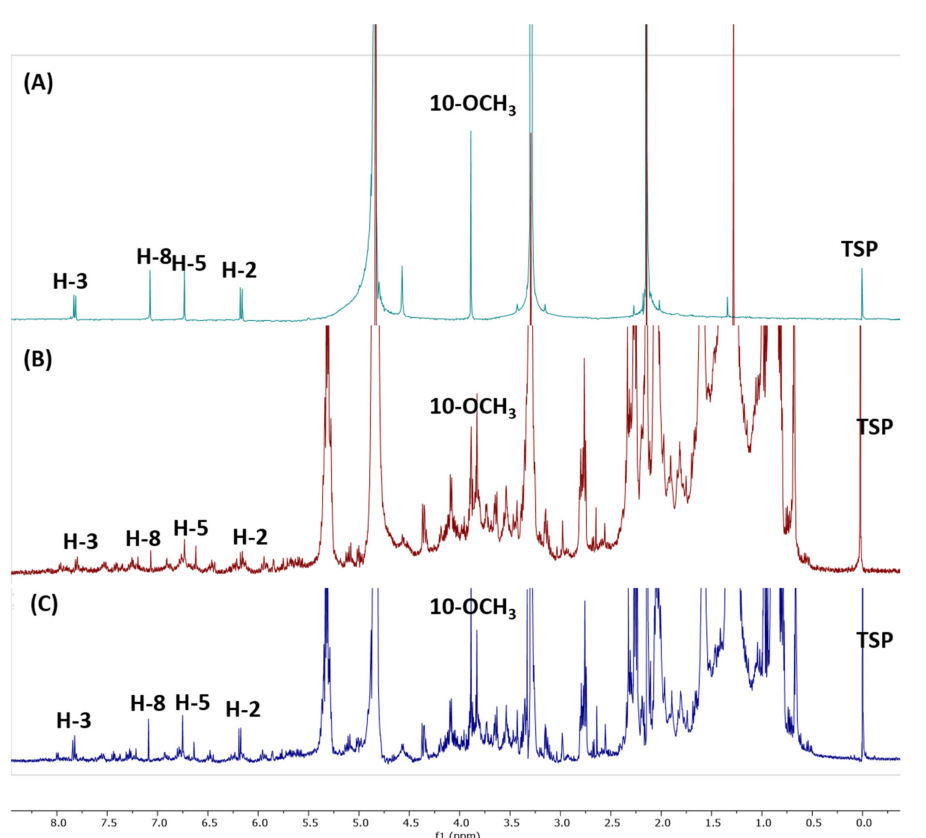
Figure 3. Stacked spectra of scopoletin standard ( A ), Paederia foetida twig chloroform extract before recovery analysis ( B ), and Paederia foetida twig chloroform extract after recovery analysis ( C